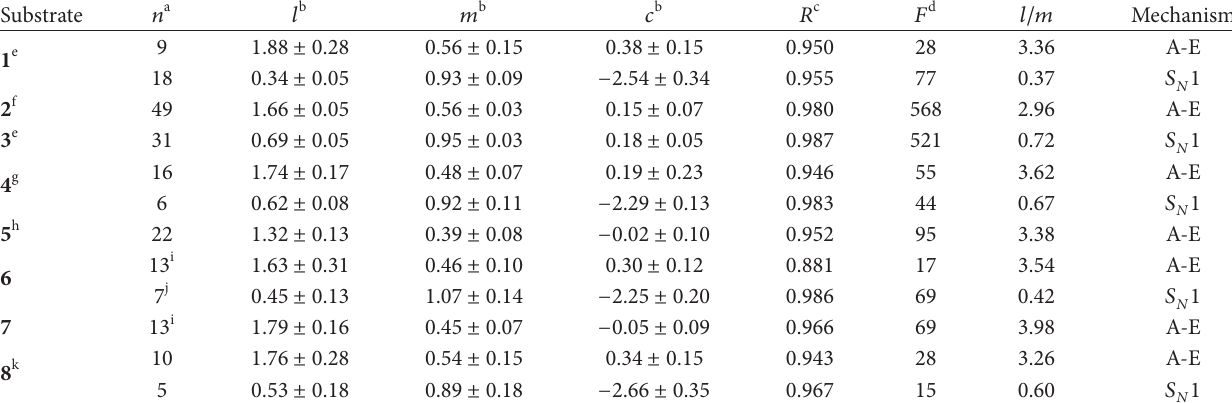
is the number of solvents. b With associated standard error. c Correlation coefficient. d g Values taken from [28]. h Values taken from [49]. i Excluding the data points in aqueous HFIP, aqueous TFE, and 80T-20E in regression calculations. j Using 𝑛𝑛 only the data points in aqueous HFIP, aqueous TFE, and 80T-20E in regression calculations. k Values taken from [40]. 1−1.5−1−0.500.51